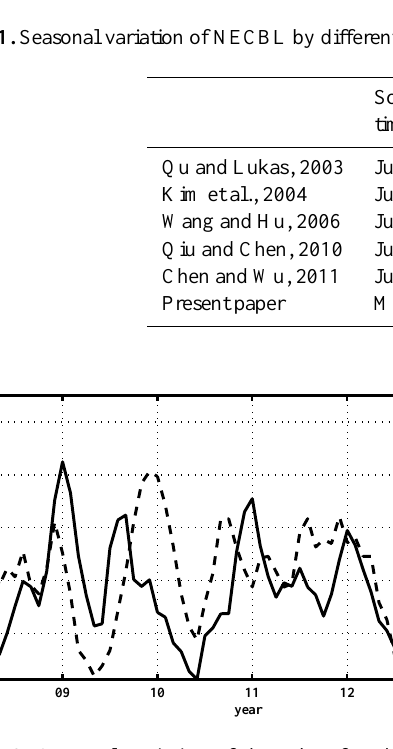
Figure 9. Seasonal variation of the subsurface high-salinity wa- ter (SHSW) in the northern SCS and the NEC bifurcation latitude (NECBL) (all normalized after applying a 3-month smoothing av- erage). The correlation coefficient between them is 0.27 (98% con- fidence).